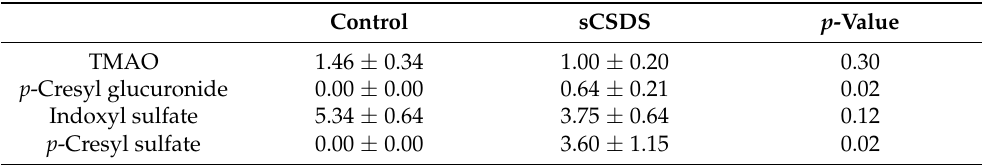
Table 3. Effects of sCSDS on the putrefactive metabolites in blood plasma of BALB/c male mice ( µ mol/L plasma) (Control mice; n = 4, sCSDS mice; n = 7). Control sCSDS p -Value TMAO 1.46 ±